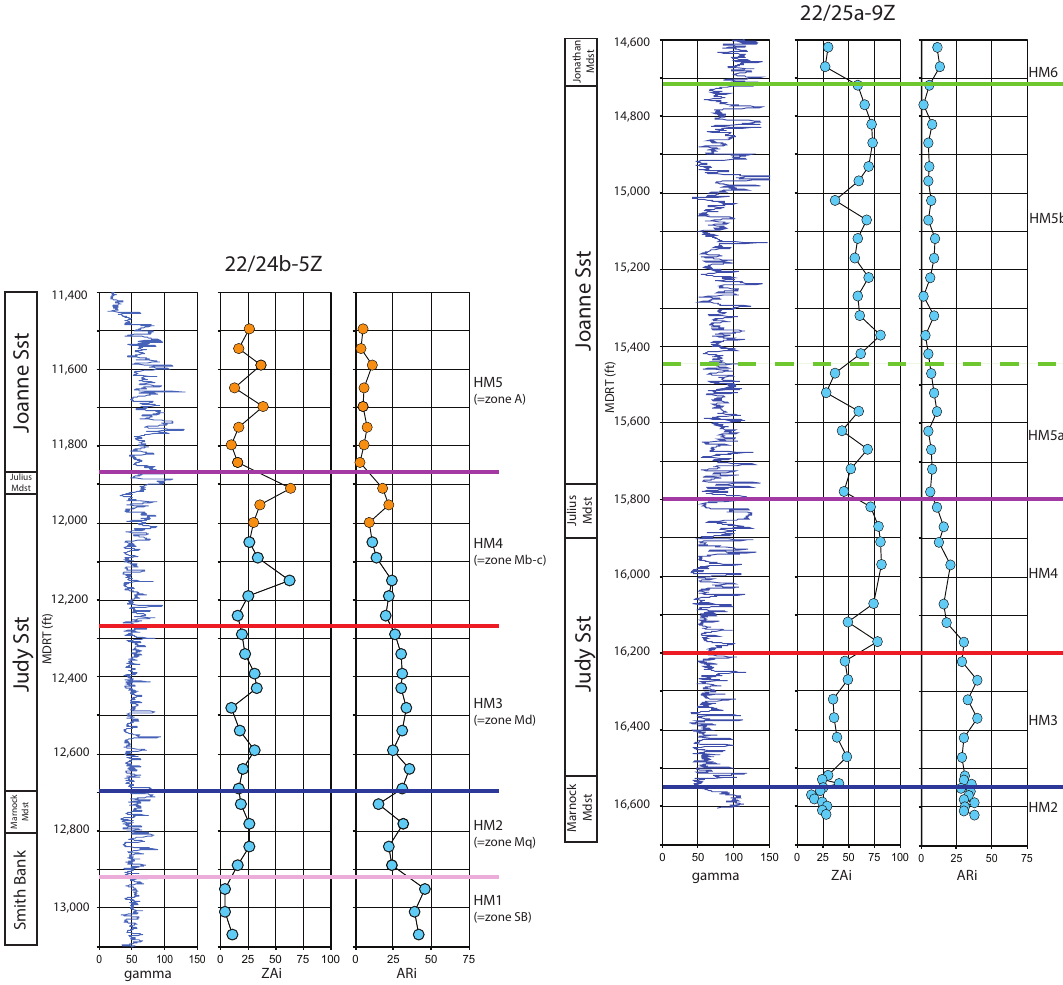
Figure 6. Heavy mineral zonation of the Triassic Skagerrak Formation in Marnock Field well 22/24a-5 and Culzean Field well 22/25a-9Z using apatite roundness index (ARi) and zircon:apatite index (ZAi), after Mouritzen et al. [48]. For 22/24b-5Z, note the correspondence between the Mouritzen et al. zonation [48] and the earlier subdivision by Mange-Rajetzky [34], as shown in Figure